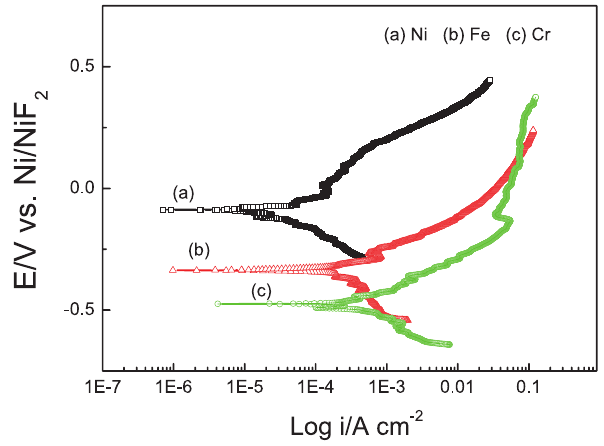
Fig. 2: Potentiodynamic polarization curves for Ni, Cr and Fe in molten (Li,Na,K)F at 973 K